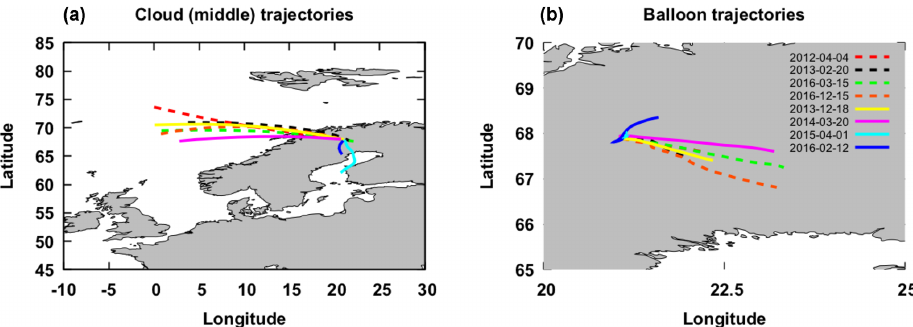
Figure 3. (a) The 24h back trajectories of the average cloud height air mass for all days are shown and (b) the trajectories of the balloon measurements (dashed lines: in situ origin, solid lines: liquid origin). The air mass back trajectory latitudes and longitudes are calculated by CLaMS. The balloon coordinates were measured by the RS92 sonde.